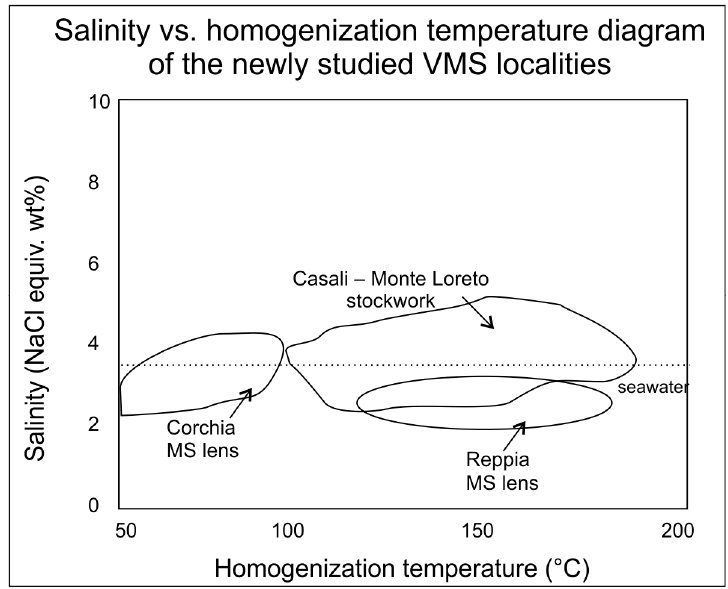
Figure A2. Salinity vs. homogenization temperature diagram of the newly studied VMS localities (quartz and calcite from the massive sulfide/MS/lenses at Corchia and Reppia and the stockwork veins of Casali–Monte